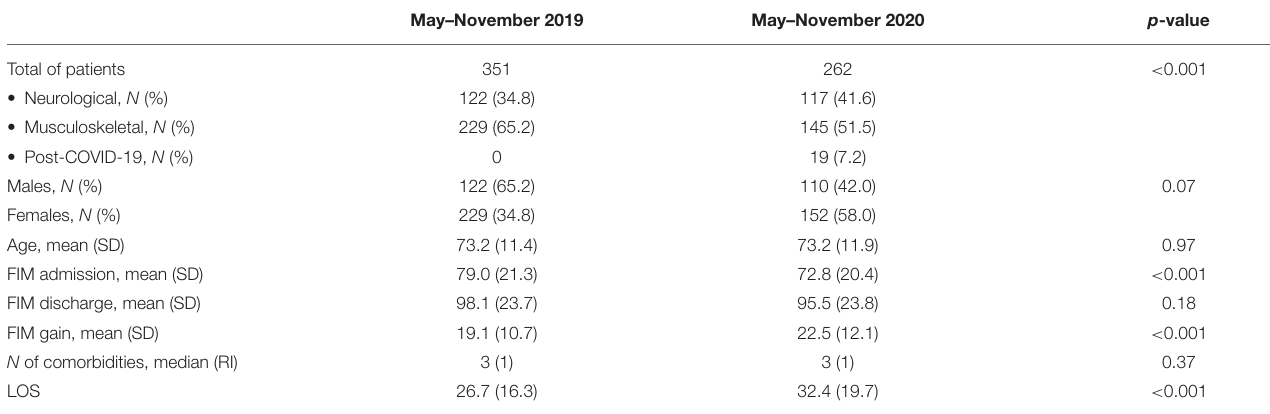
TABLE 1 | Comparison of patients’ characteristics in the two periods.